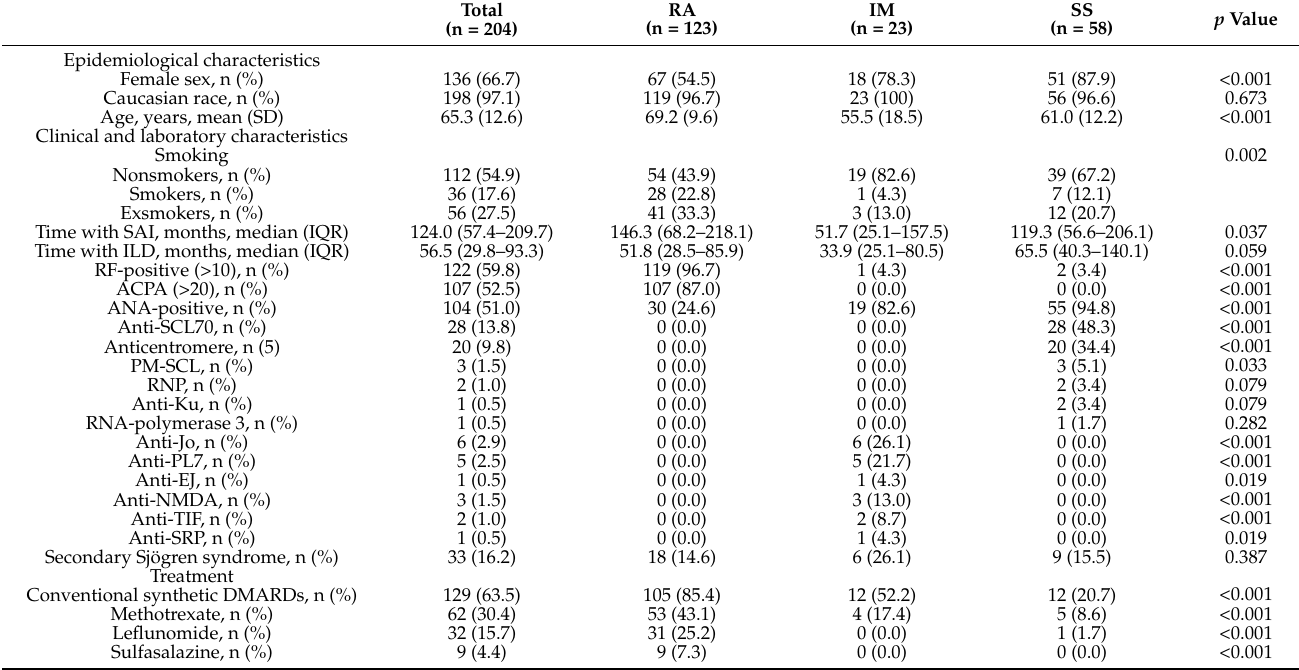
Table 1. Clinical-epidemiologic